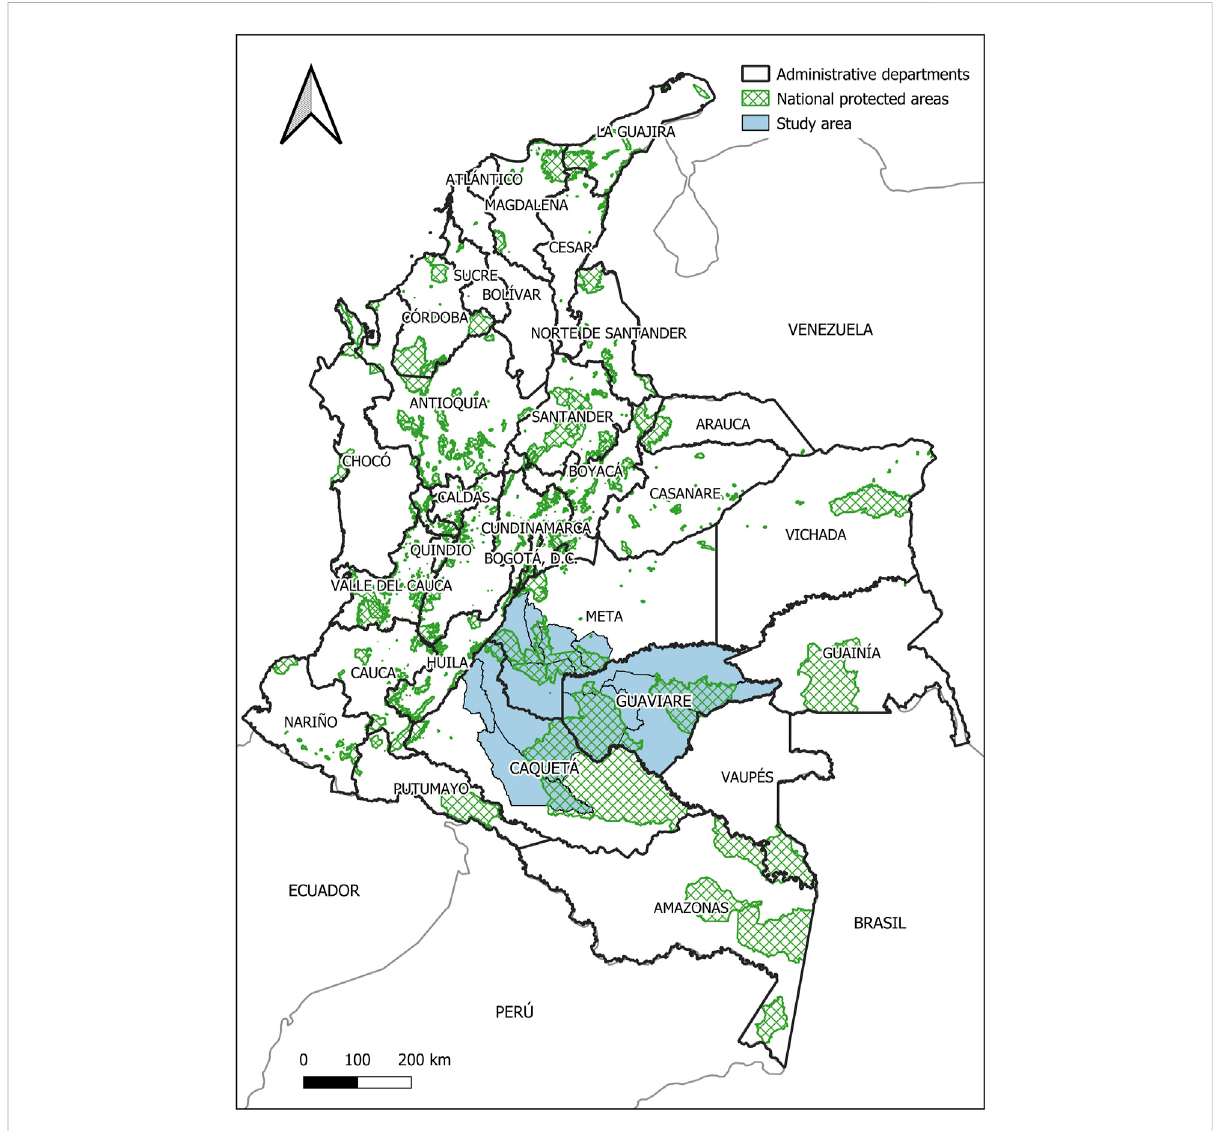
FIGURE 1 Study area (blue polygons) in the departments of Meta, Guaviare and Caquetá, Colombia. Protected areas are shown in